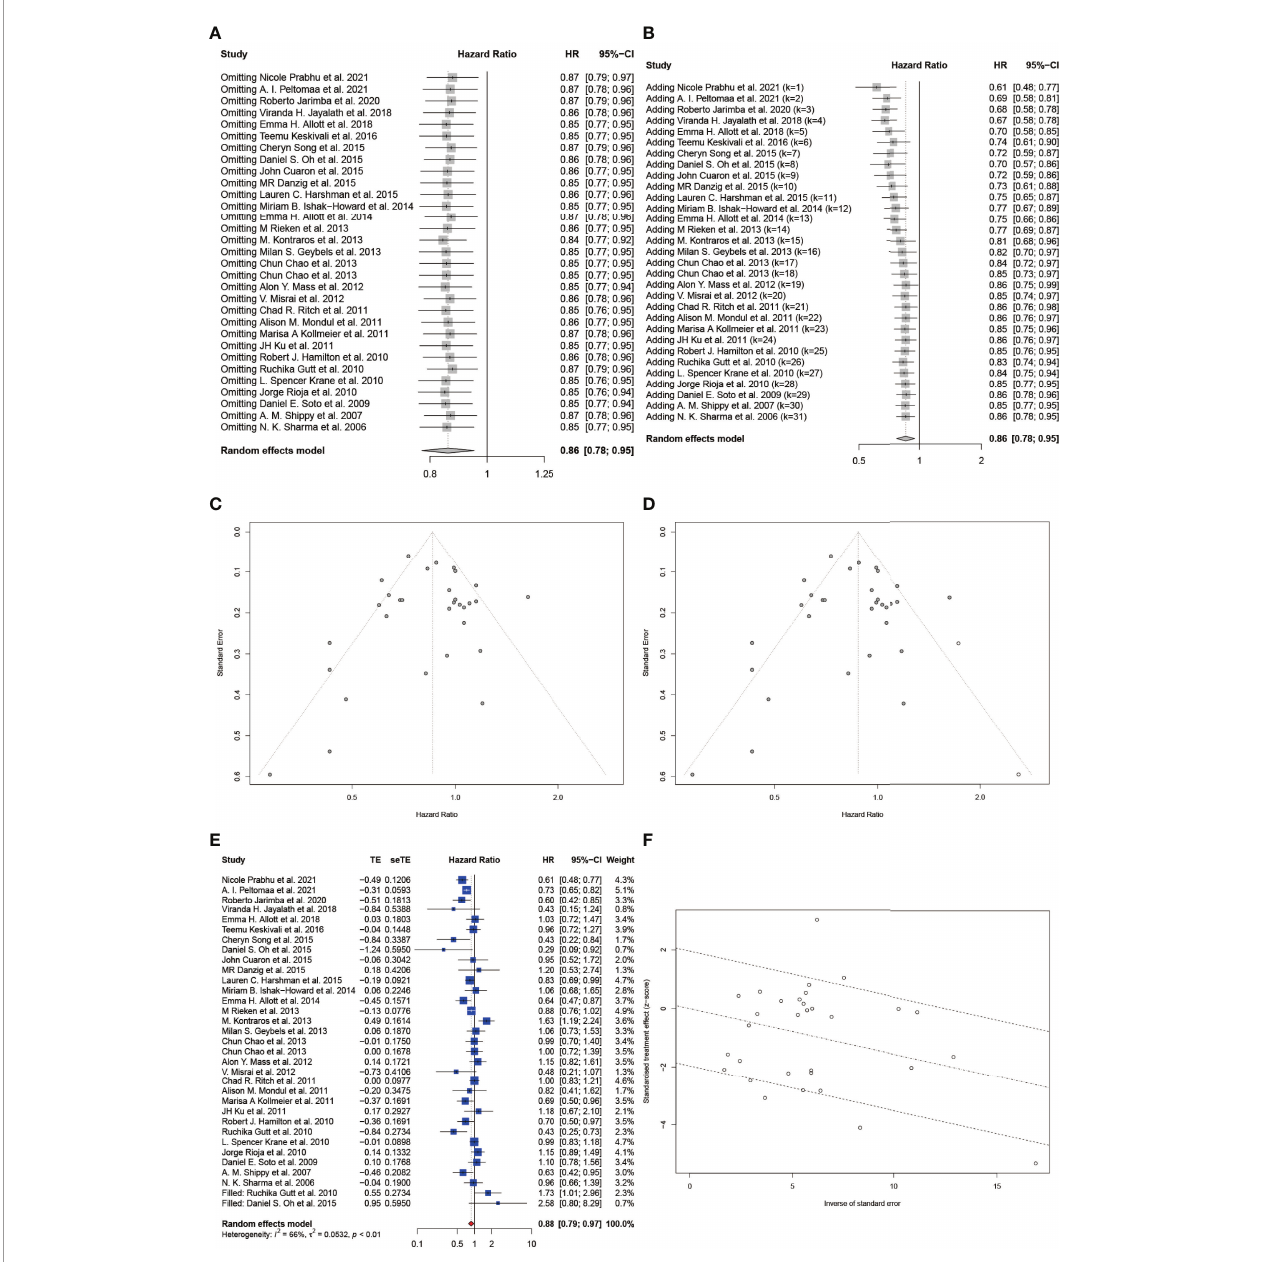
FIGURE 5 | Sensitivity analysis and the detection of publication bias for included studies on HR of BCR. (A) Sensitivity analysis by stepwise omitting the included studies. (B) Cumulative meta-analysis by stepwise adding the included studies. (C) The funnel plot. (D) The trim and fi ll funnel plot. (E) The fi lled forest plot. (F) The Galbraith plot. Effect size as z-scores plotted as a function of the inverse standard error for each study reported in the present study. The middle line is the line of best fi t, while the upper and lower dashed lines represent the upper and lower 95% con fi dence